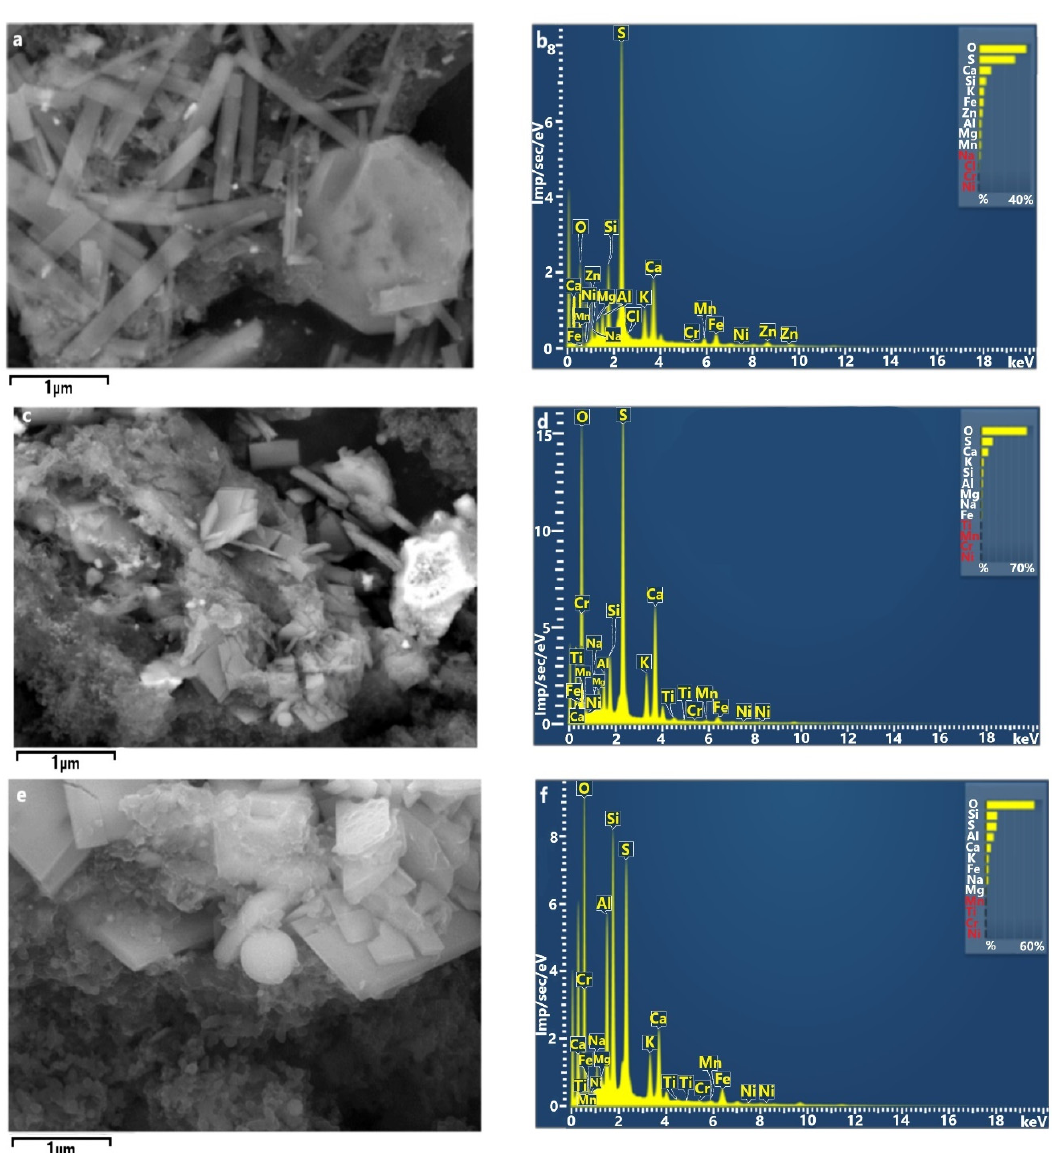
Figure 6. SEM micrograph S-rich rod-shaped, crystalline, and spherical (magnification 5000×, 3000×, and 10,000×) particles ( a , c , e , respectively) and their EDS spectrum ( b , d , f , respectively).